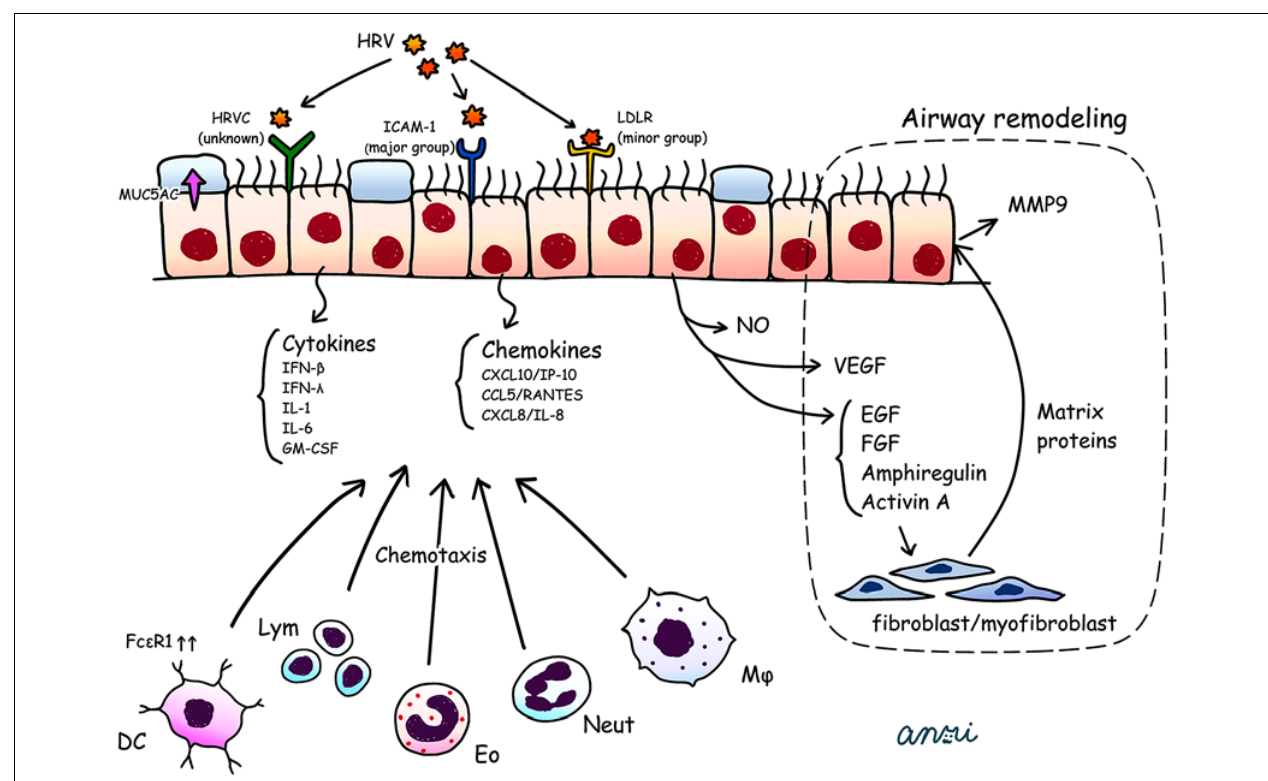
FIGURE 1 | HRV attaches to airway epithelial cells via ICAM-1, LDLR, and unknown receptors for HRV-C. HRV infected bronchial epithelial cells secrete a wide range of cytokines (IFN- β , IFN- λ , IL-1, IL-6, GM-CSF) and chemokines (CXCL10/IP-10, CCL5/RANTES, CXCL8/IL-8) together with NO, VEGF, and EGF, FGF, amphiregulin and activin A.These cytokines and chemokines attract various inflammatory cells such as DCs with upregulation of Fc ε R1, lym, Eo, Neut, and M φ .TheVEGF, EGF, FGF, amphiregulin and activin A promote the release of matrix proteins from fibroblasts/myofibroblasts, which enhance the production of MMP9 from airway epithelial cells.These